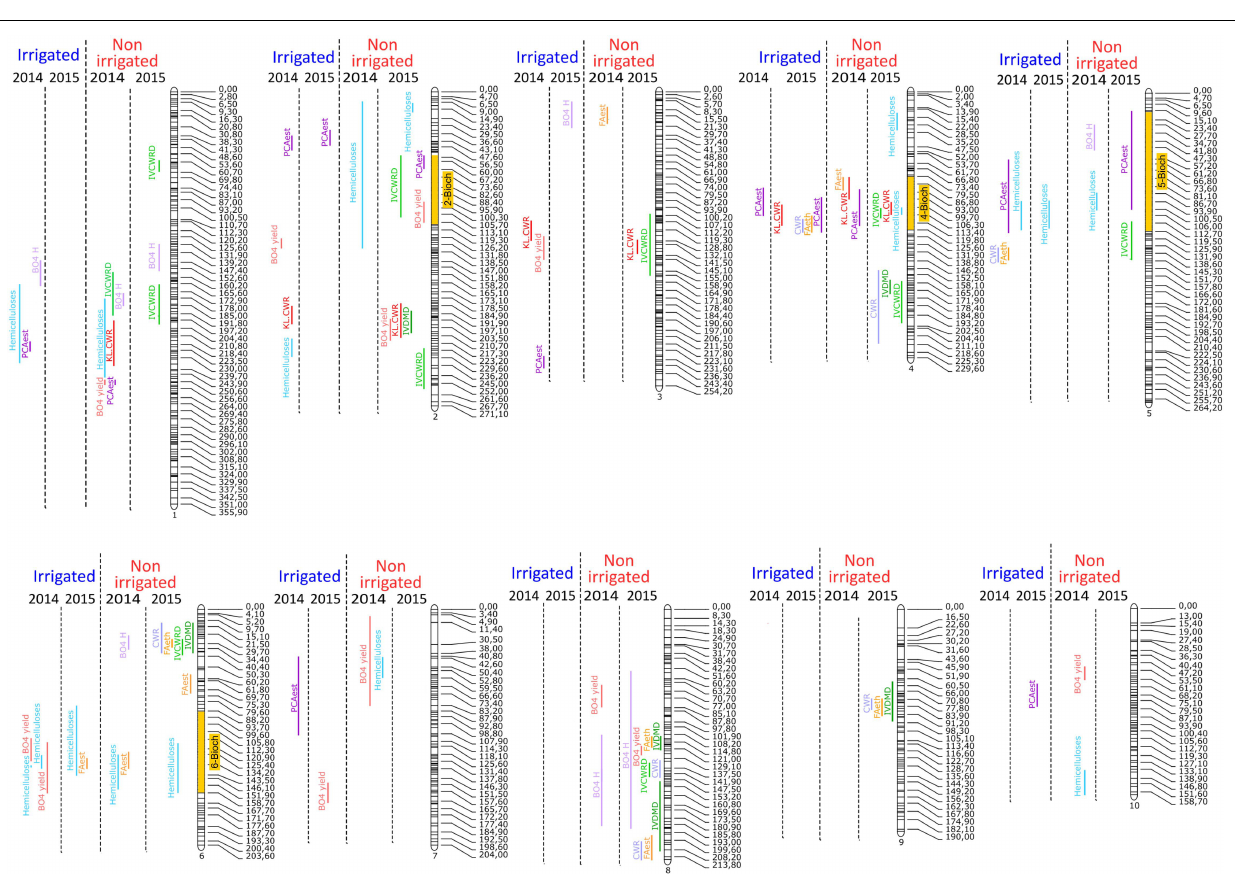
Frontiers in Plant Science |